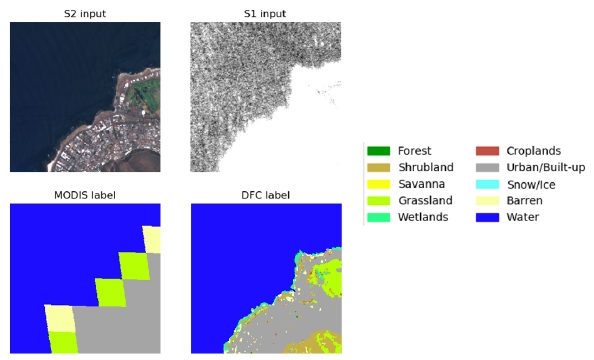
Figure 5: An example of DFC2020 quadruplets